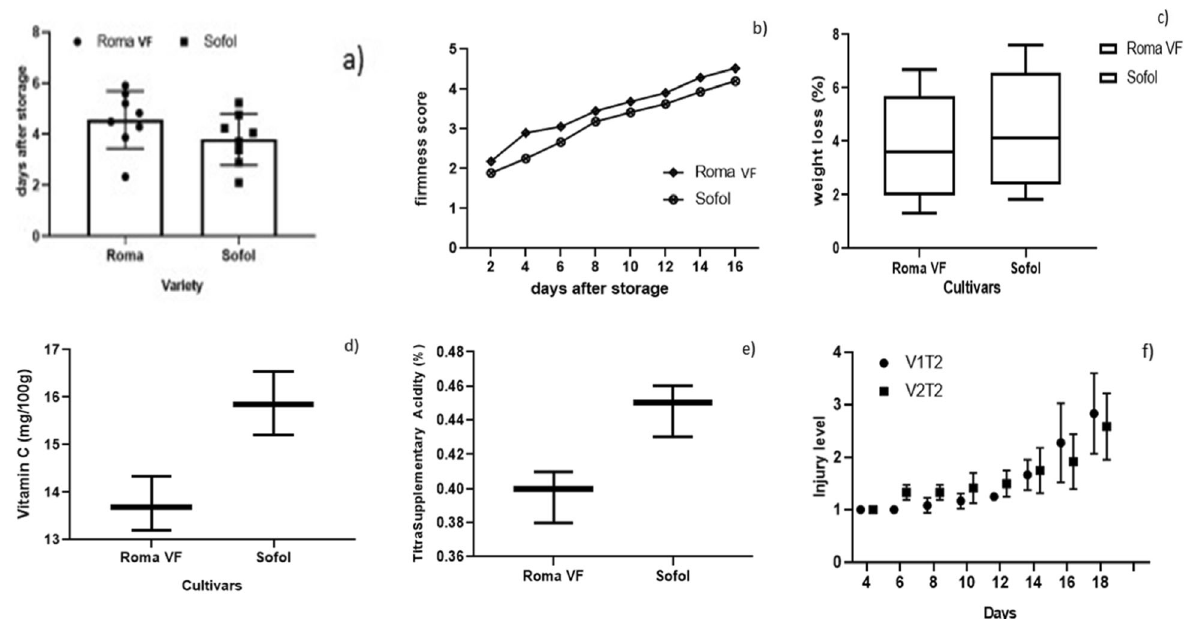
Fig. 2 Different effects of two tomato varieties under storage and ripening. a Changes of color, b fruits ’ firmness:firmness score (1 = hard, 2 = sprung, 3 = between sprung and eating ripe, 4 = eating ripe, 5 = overripe, 6 = rotten), c total weight loss, d – e vitamin C content and titratable chilling injury)